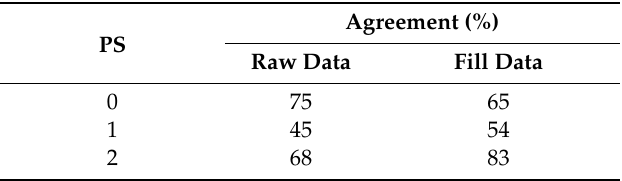
Table 6. Percentage of agreement (minute by minute) between observed panting score (PS) and sensor-recorded panting states for raw and fill datasets. Agreement (%) PS Raw Data Fill Data 0